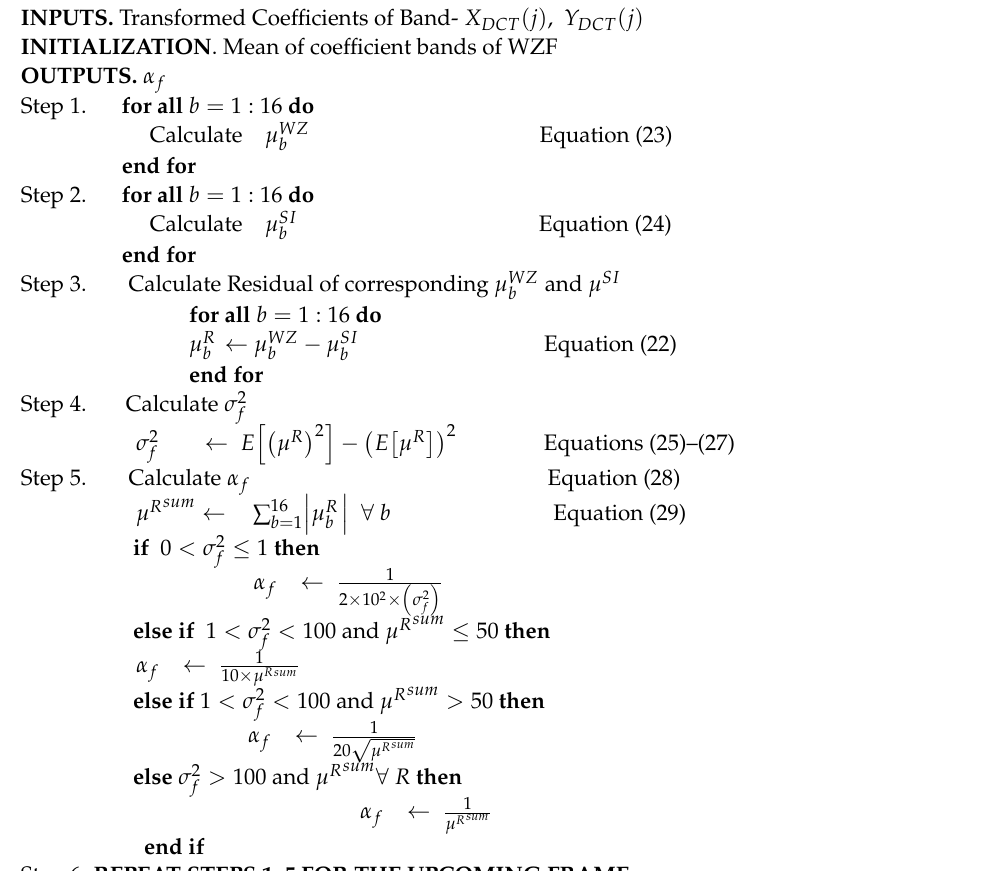
Algorithm 2 Determine the Steps for Calculation of Laplacian Distribution Parameter α f under Proposed Online Correlation Noise Model Methodology